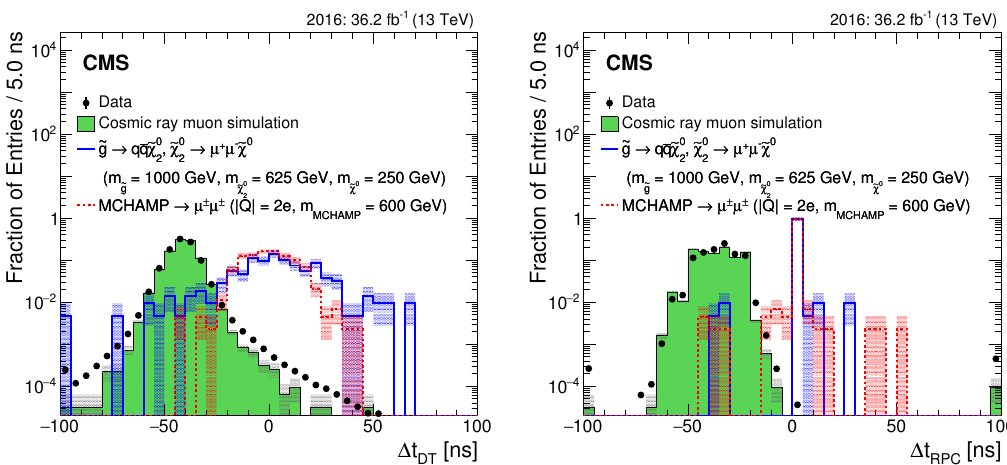
Figure 1 . The (cid:1) t DT (left) and (cid:1) t RPC (right) distributions for 2016 data, MC simulated cosmic ray muon, 1000 GeV gluino signal, and 600 GeV MCHAMP signal events, for the muon search. The events plotted pass a subset of the full analysis selection that is designed to select good-quality DSA muon tracks but does not reject the cosmic ray muon background. The number of cosmic ray muon background events is greatly reduced when the full selection is applied, as we require (cid:1) t DT > (cid:0) 20 ns and (cid:1) t RPC > (cid:0) 7 : 5 ns. The gray bands indicate the statistical uncertainty in the simulation. The histograms are normalized to unit